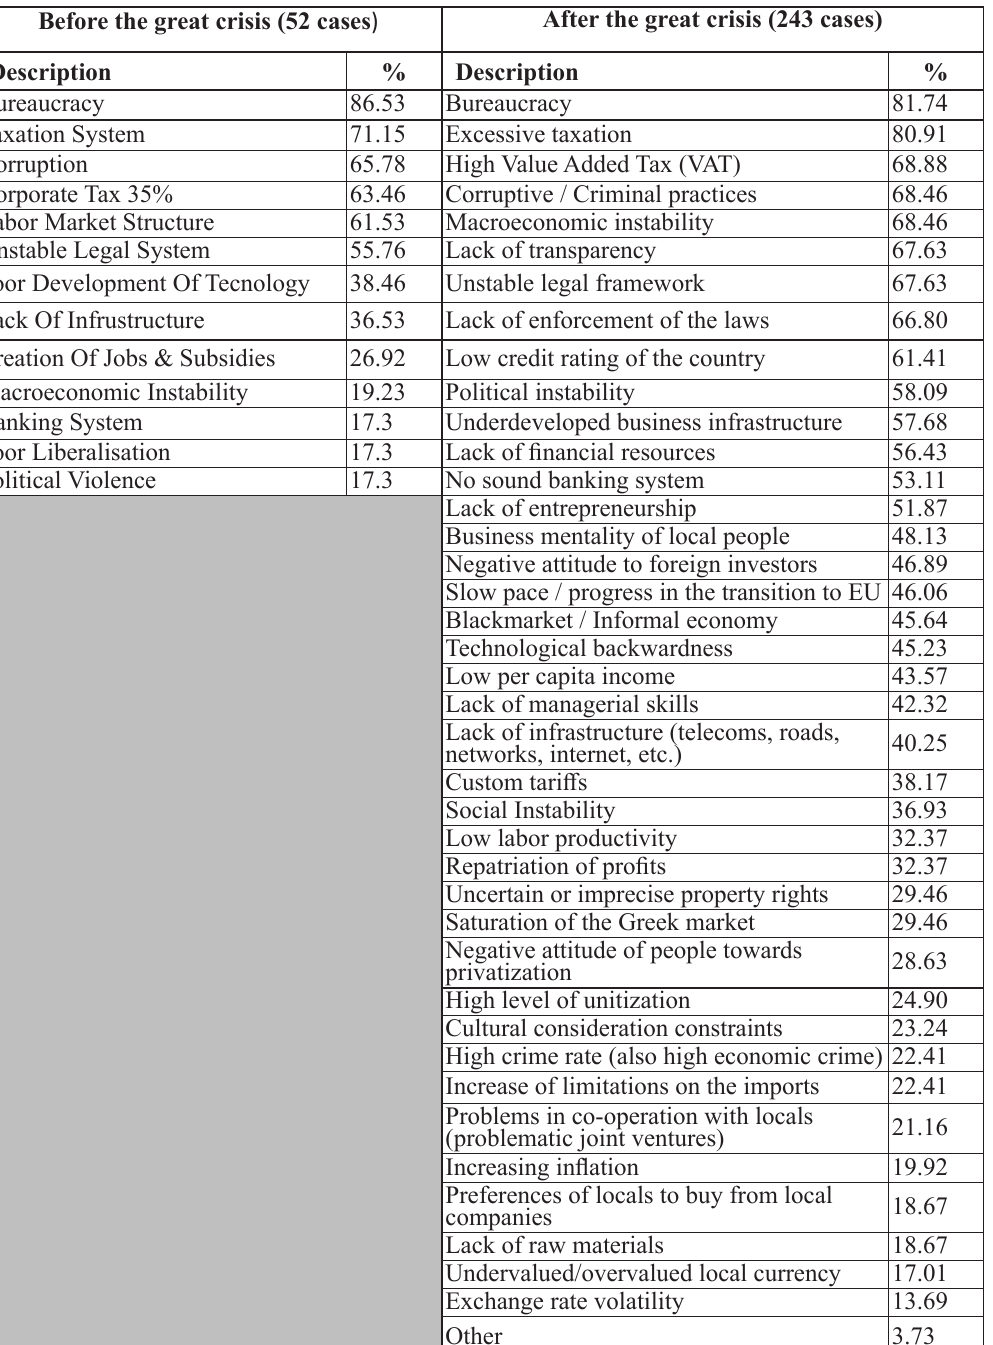
Table 3: Barriers faced by MNEs Operating in Greece Before the great crisis (52 cases